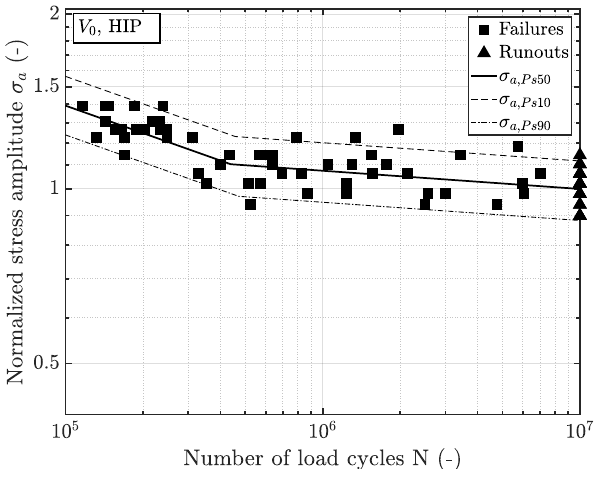
Figure 5. S/N curve of near defect free position A.